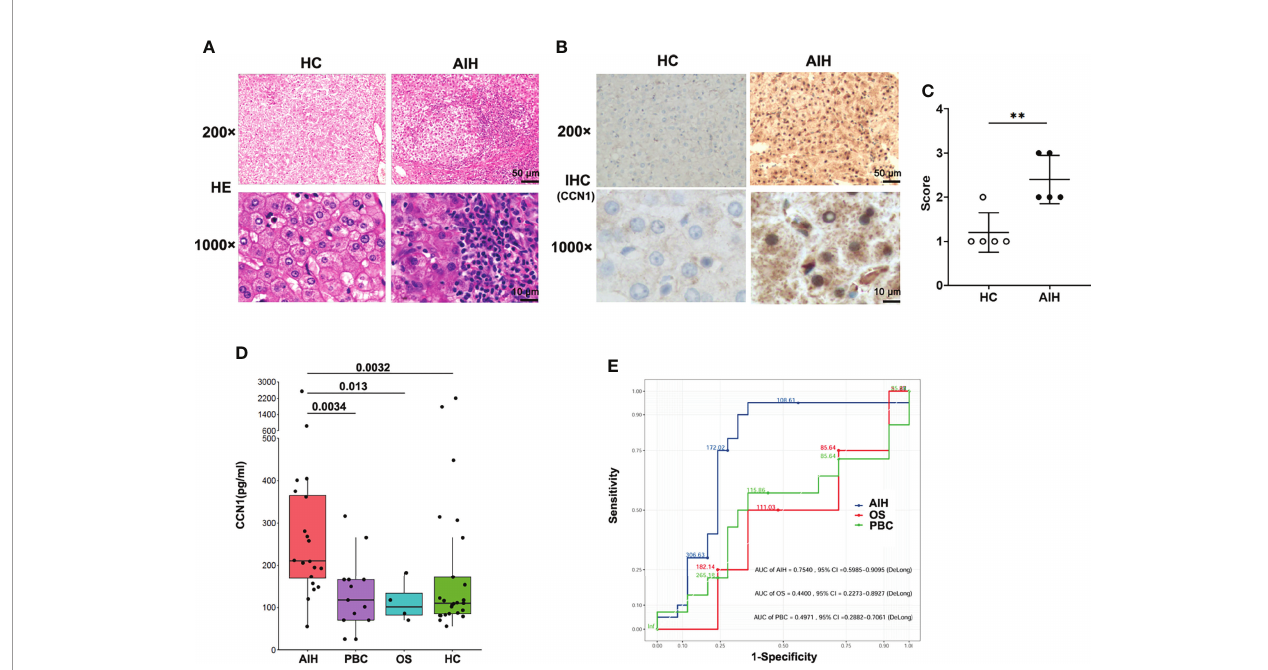
FIGURE 2 | Diagnostic value of CCN1 in AIH patients. (A) Representative H&E staining images of liver tissues from healthy control and AIH patients. Original magni fi cation ×200 (upper, scale bar: 50 µm), ×1000 (bottom, scale bar: 10 µm). (B) Representative IHC staining images of CCN1 in liver tissues from healthy control and AIH patients. Original magni fi cation ×200 (upper, scale bar: 50 µm), ×1000 (bottom, scale bar: 10 µm). (C) Quanti fi cation of IHC staining for CCN1 using IHC pro fi ler. The IHC score was expressed as described in methods section. (D) CCN1 levels in serum from AIH patients (n= 20), PBC patients (n= 13), OS patients (n= 4) and HC controls (n= 25). (E) ROC analysis was performed to evaluate the performance of CCN1 in distinguishing AIH (blue), OS (red) or PBC (green) from HC.